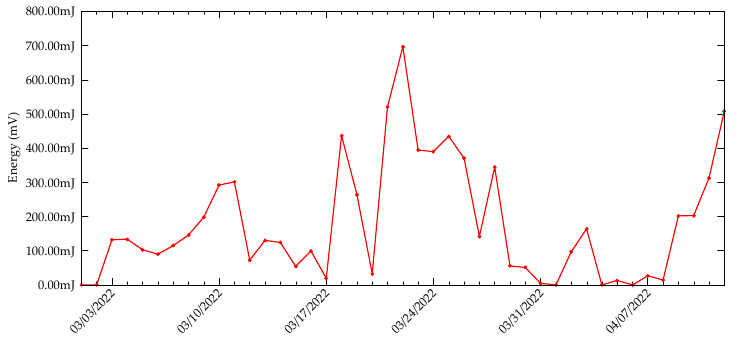
Figure 15. Energy harvested from the harvesting system installed in the CDE campus of University of